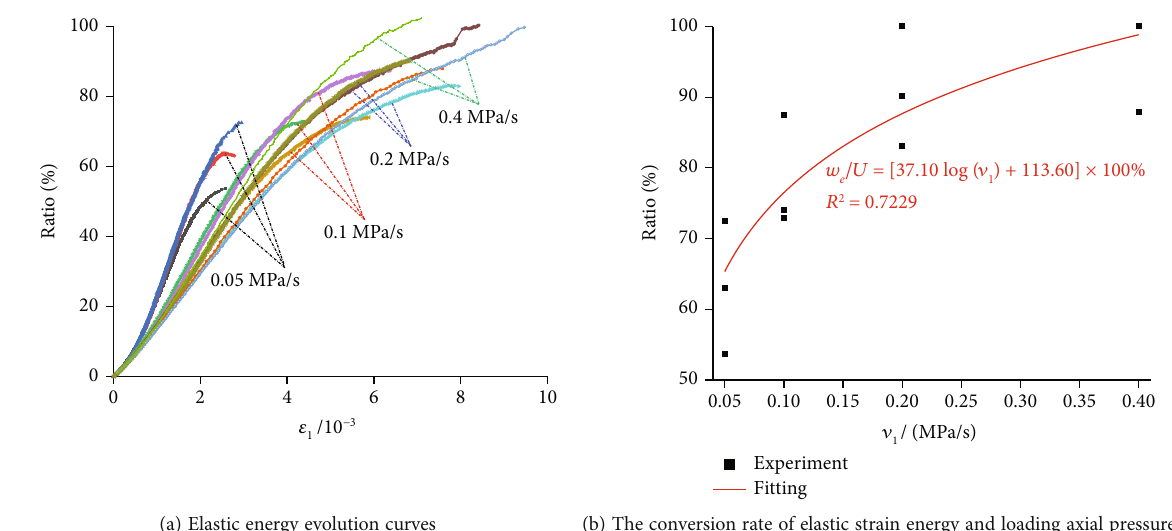
(b) The conversion rate of elastic strain energy and loading axial pressure rate Figure 9: Elastic strain energy conversion